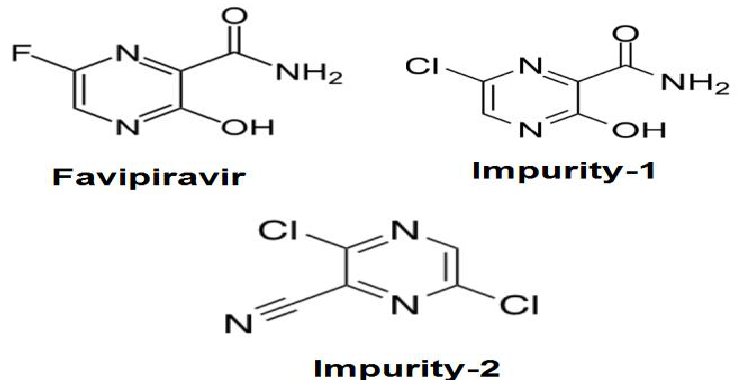
Figure 1. The chemical structures of FAV, impurity-1, and